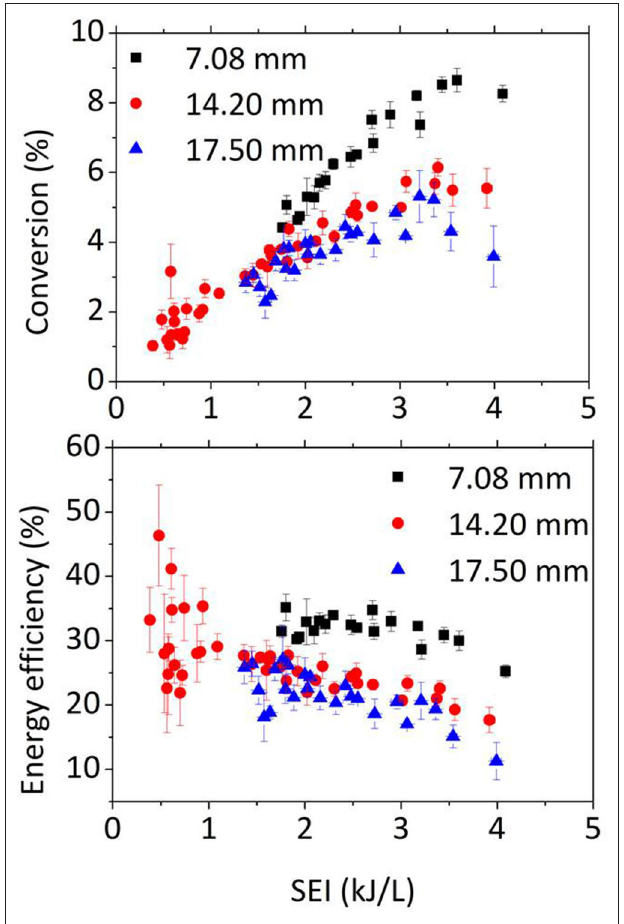
FIGURE 11 | Measured conversion and energy efficiency as a function of SEI, in a gliding arc plasmatron (GAP) at atmospheric pressure, for three different reactor outlet diameters, as indicated by the legend. Adopted from Ramakers et al. (2017) with permission.